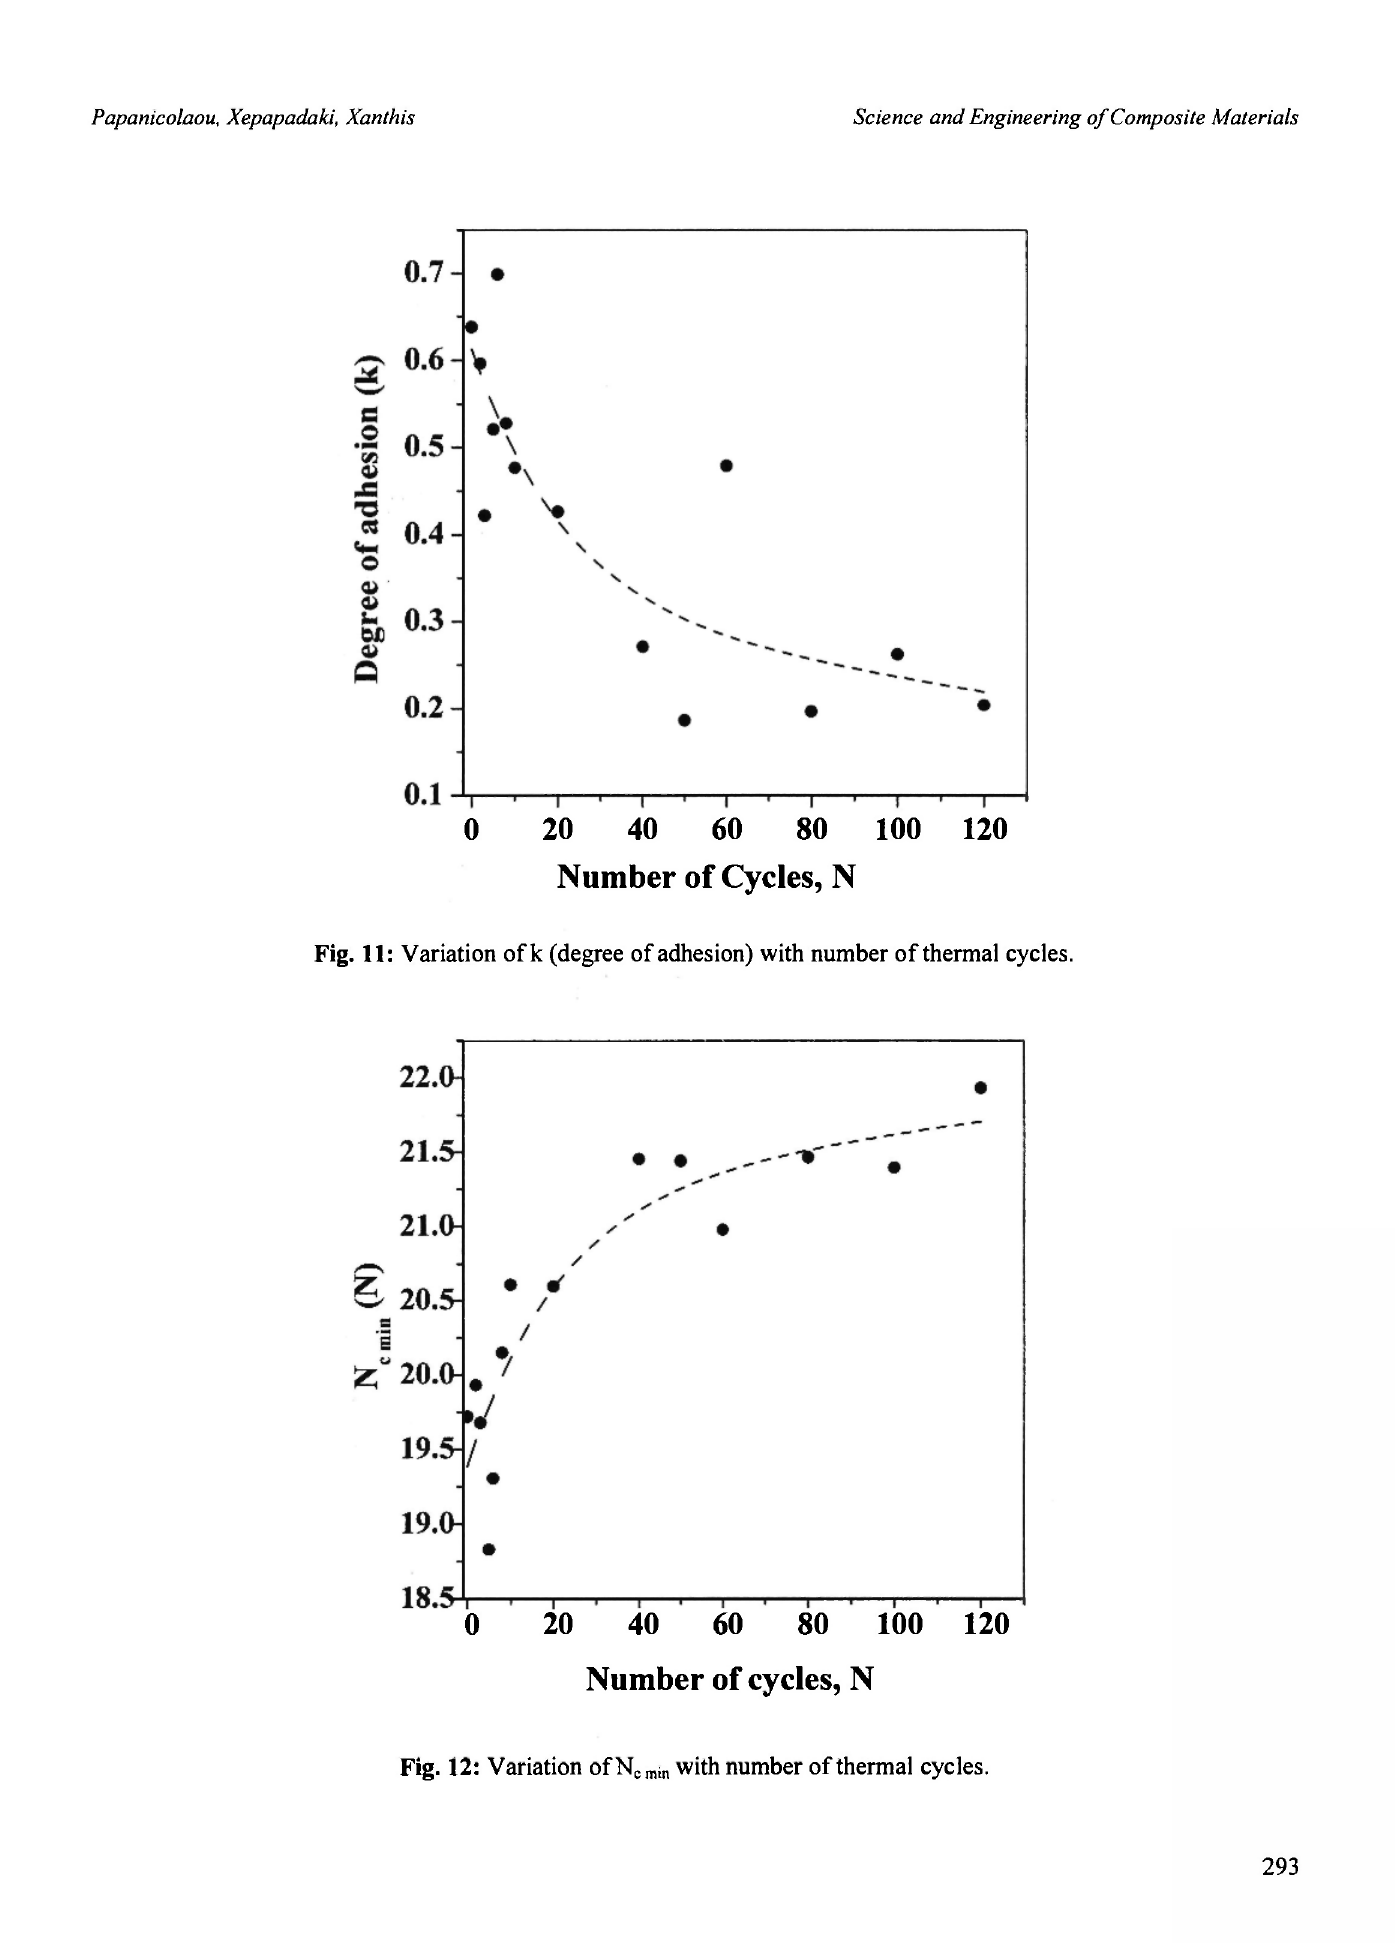
Fig. 12: Variation of N cmin with number of thermal